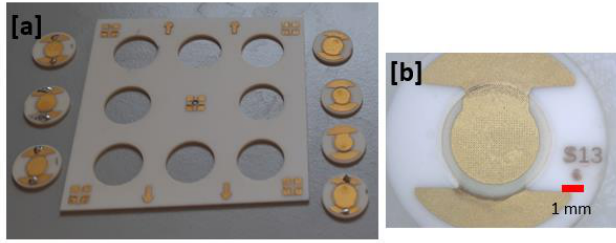
Figure 3 :[a] Alumina substrate with 8 elements cutting by UV LASER [B] Individual piezoelectric element ready to be integrated on a cavity